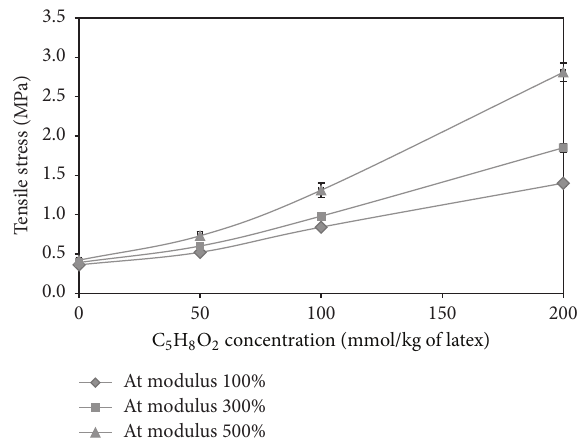
Figure 8: Tensile stress at 100%, 300%, and 500% modulus of NR obtained from the fresh NR latex treated with different concentra- tions of C 5 H 8 O 2